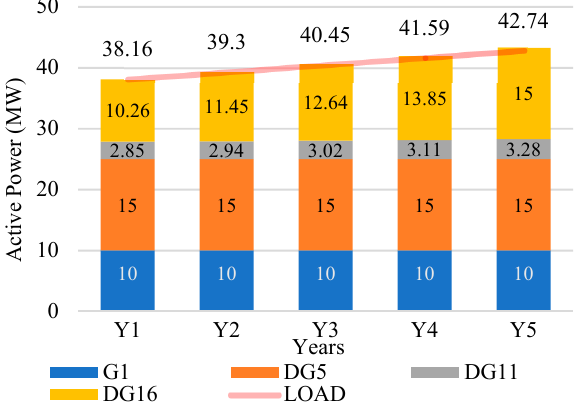
Figure 3. Scenario S7: total demand and generation under ANM.